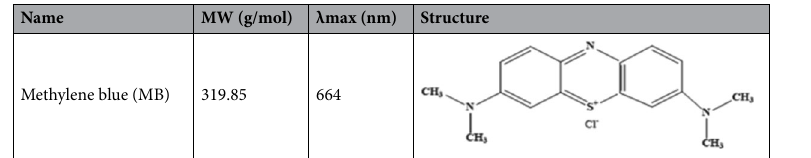
Table 1. The chemical structure of methylene blue.